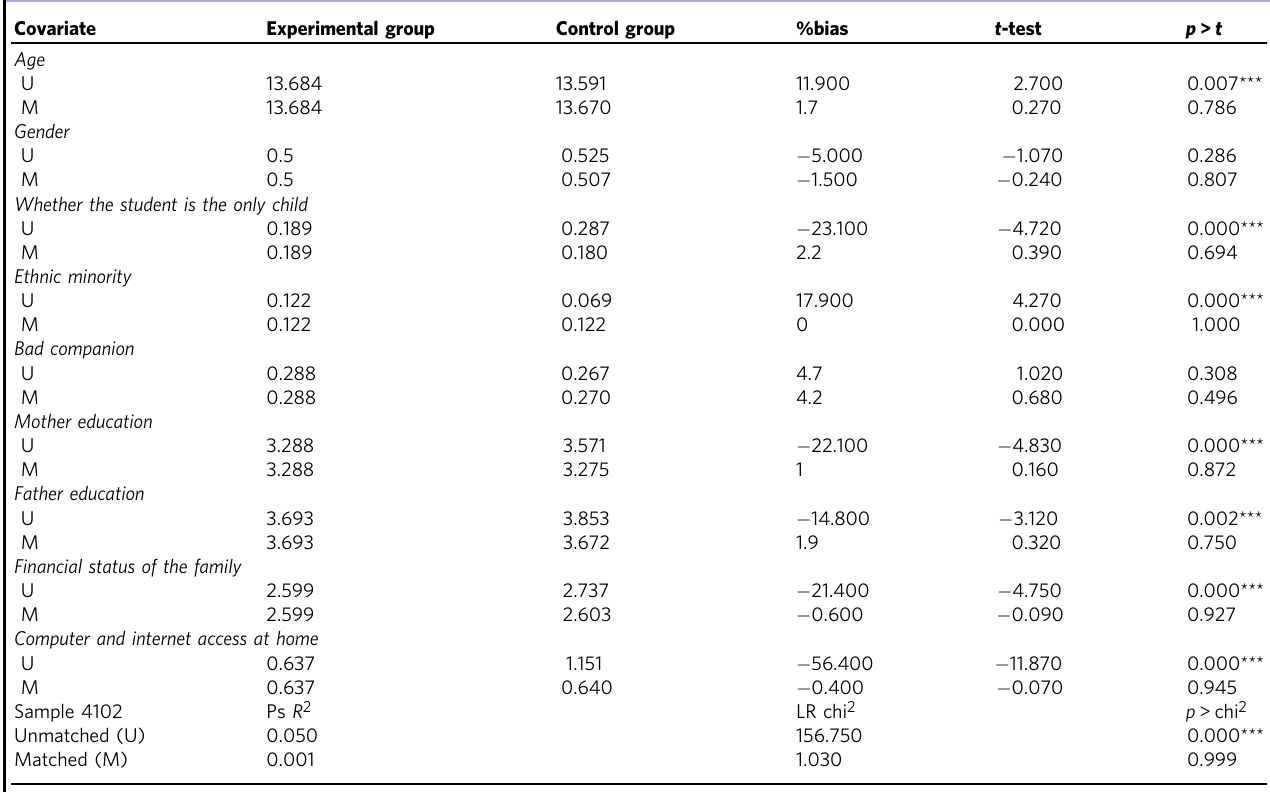
Table 6 Matching balance test on the model of both parent ’ s